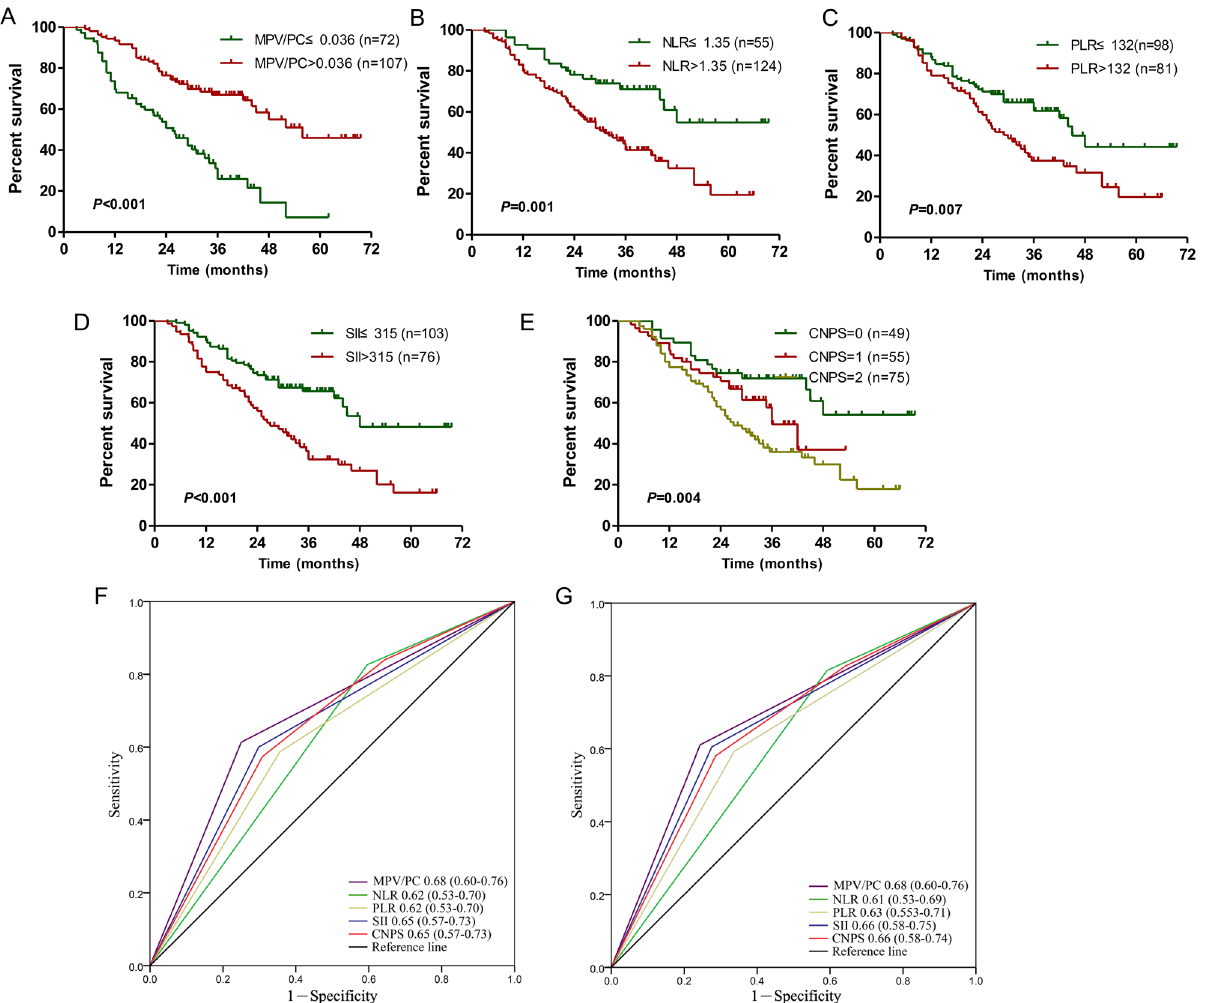
Figure 2. The prognostic significance of preoperative MPV/PC ( A ), NLR ( B ), PLR ( C ), SII ( D ), and CNPS ( E ) in gastric cancer in the validation cohort. Predictive ability of the MPV/PC in gastric cancer was compared with NLR, PLR, SII and CNPS by ROC curves in 3-years ( F ) and 5-years ( G ) in the validation